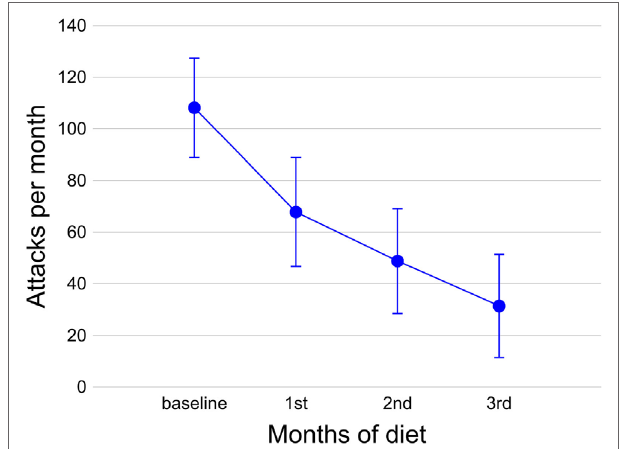
FigUre 1 | Number of attacks during the diet in 18 chronic cluster headache patients. Circles indicate the mean number of attacks per month at the baseline and during the 3 months of diet; bars indicate the SEM.